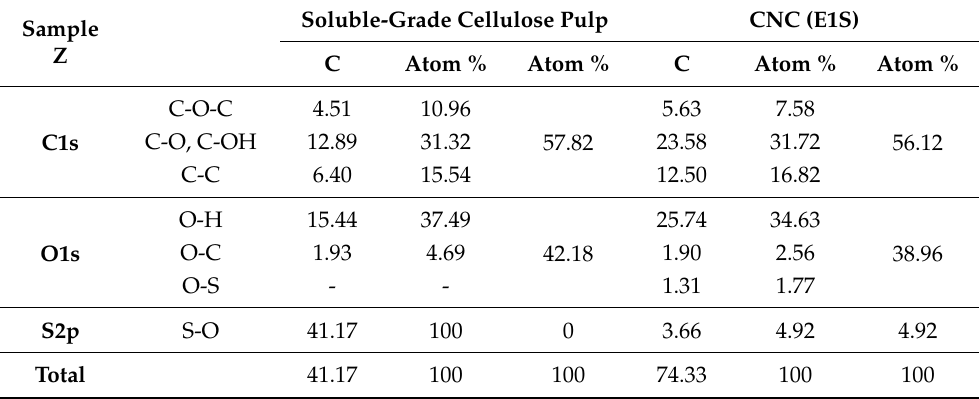
Figure 3. High resolution spectra for soluble-grade cellulose pulp: ( a ) C1s, ( b ) O1s, and CNC-S: ( c ) C1S, ( d ) O1s, and ( e ) S2p. Table 4. XPS atomic composition of soluble-grade cellulose pulp and CNC-S